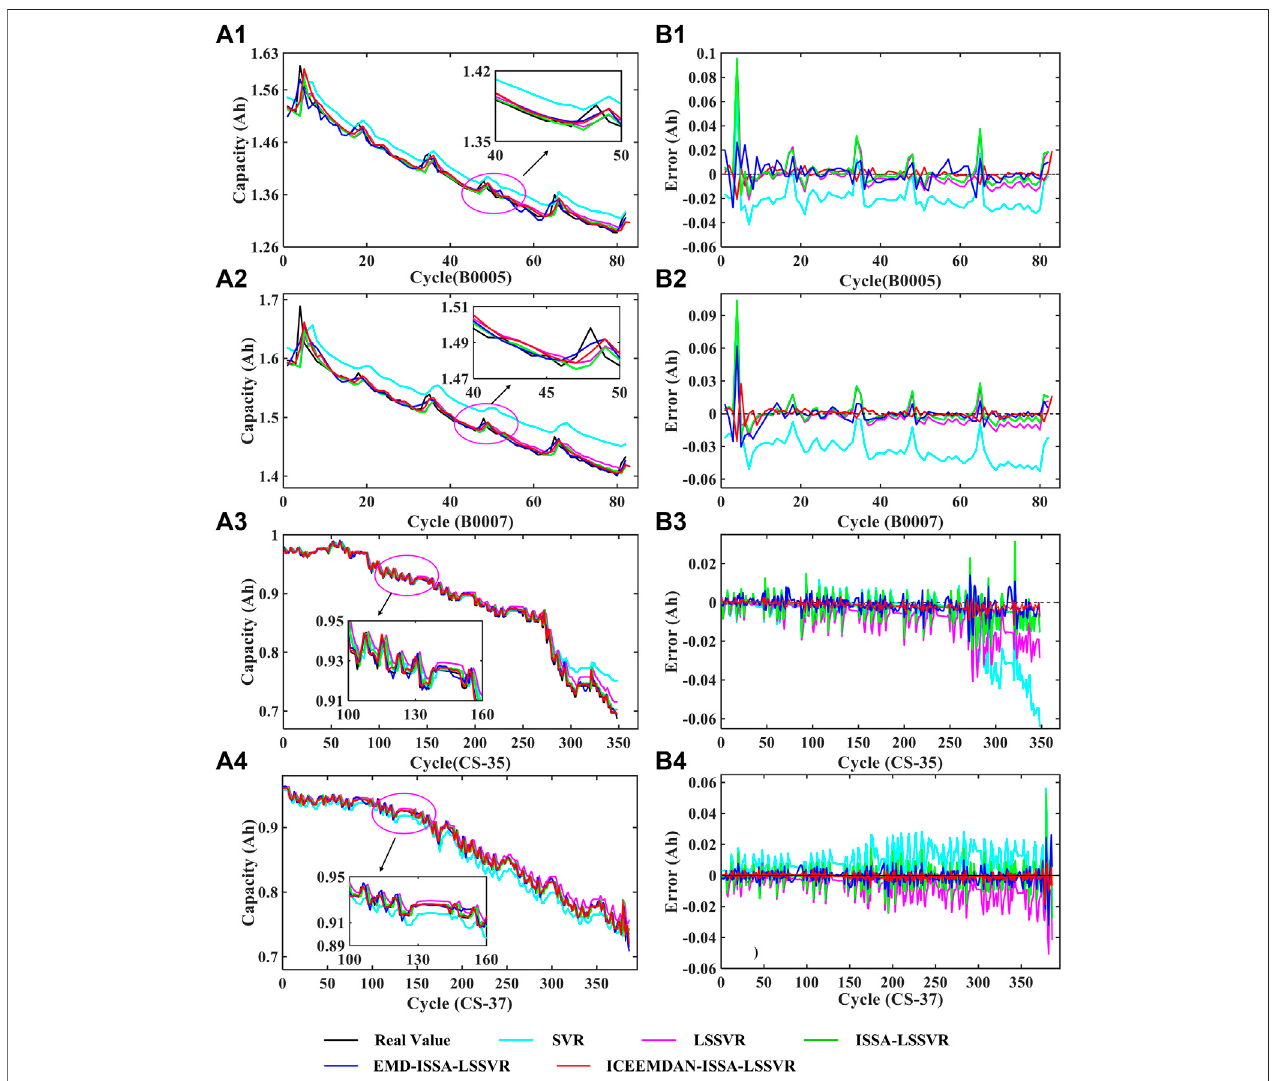
FIGURE 3 | Prediction capacity results and errors of different algorithmss (a1 – a4) is the prediction capacity. (b1 – b4) is the prediction error.